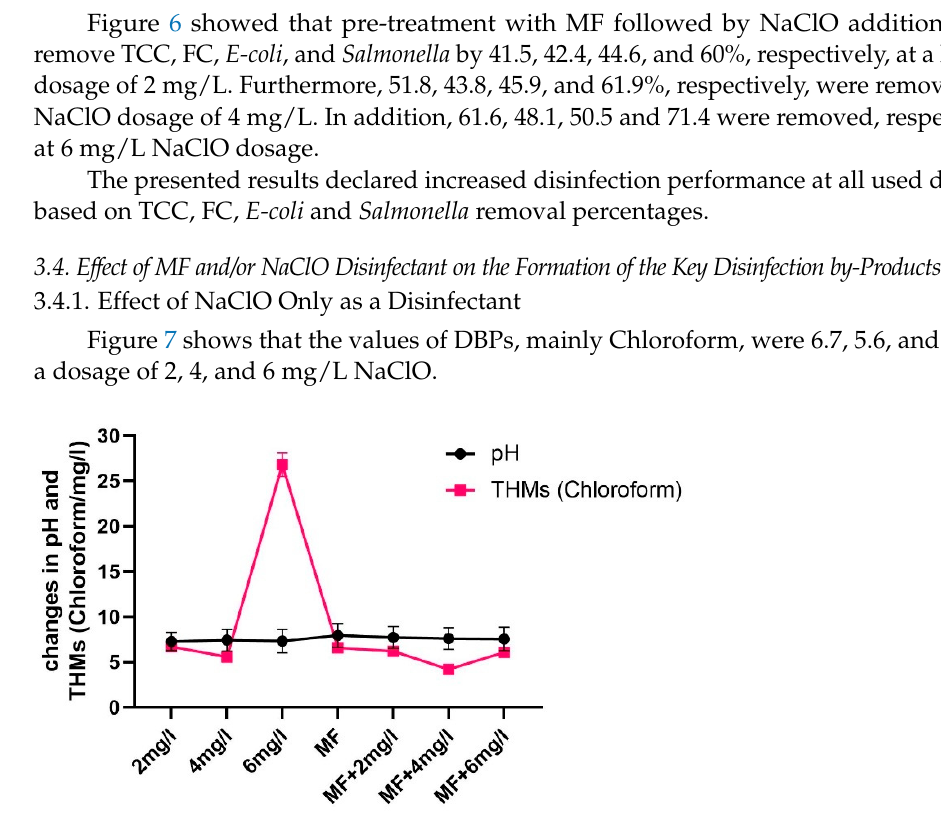
Figure 7. The level of disinfection by-products THMS (Chloroform) mg/L by different disinfection methods; (l) 2, 4, and 6 mg/L active chlorine; Disinfection with 12% ( w/v ) commercial NaClO (2) MF: disinfection with magnetic field; and (3) MF + 2 mg/L, MF + 4 mg/L, and MF + 6 mg/L; pretreatment with magnetic field then disinfection with